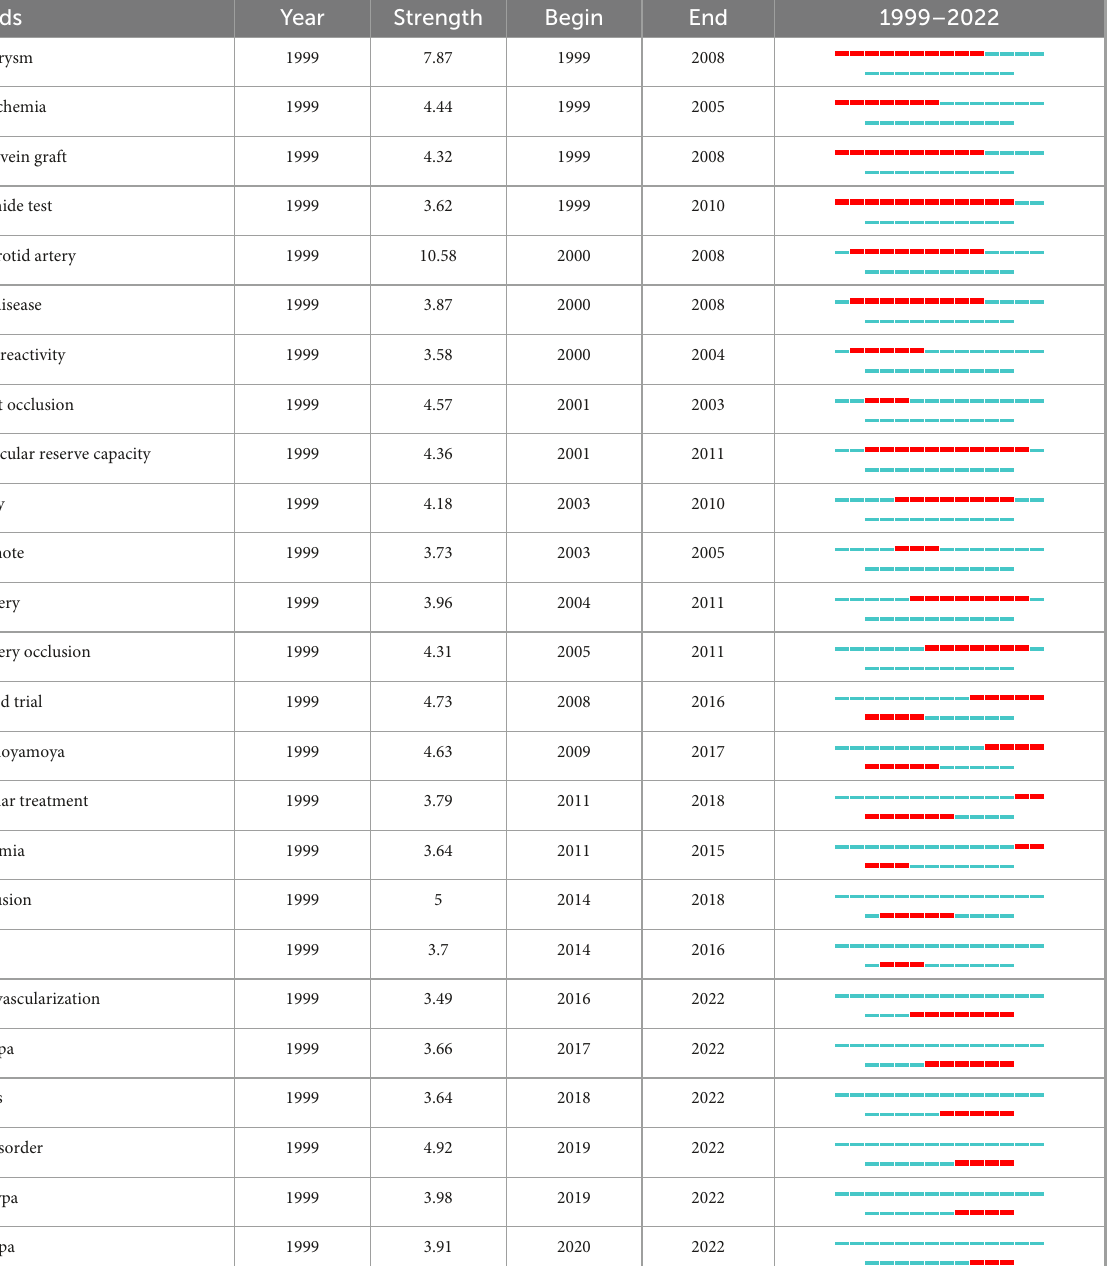
TABLE 8 Keywords with the strongest citation bursts (top